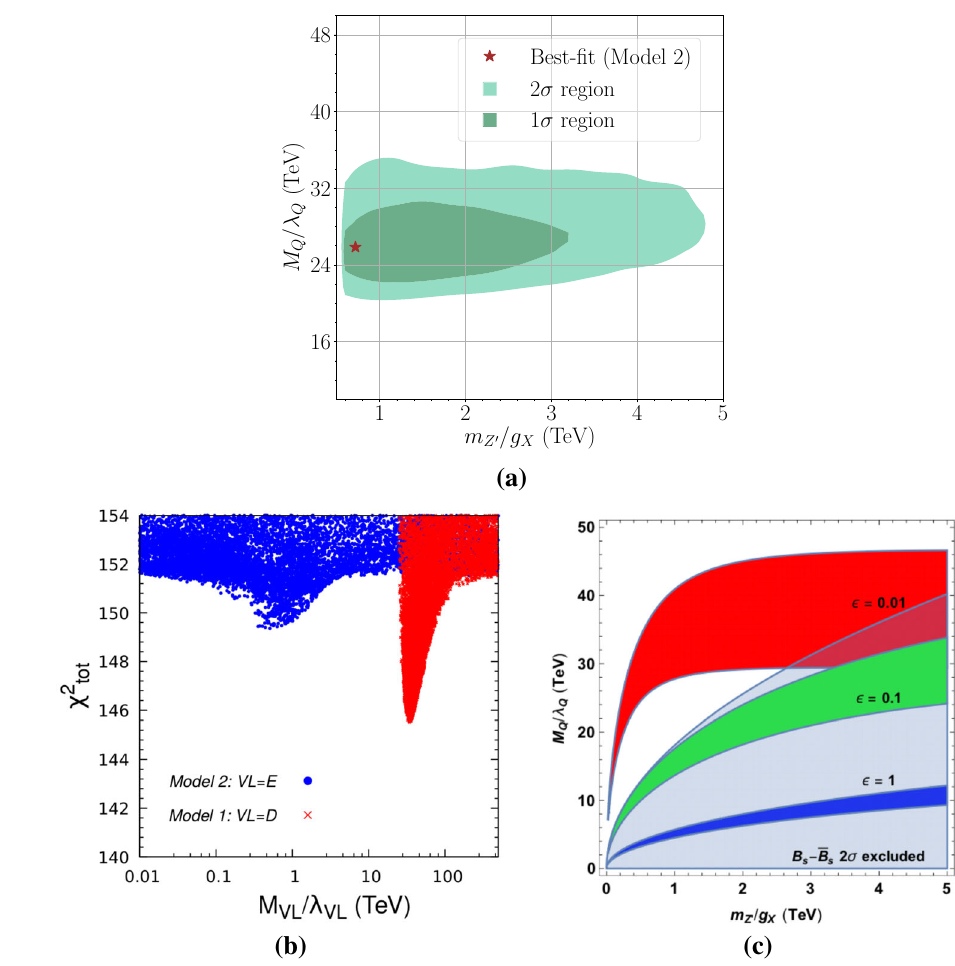
Fig. 6 a The marginalized 2-dimensional posterior pdf in the ( m Z (cid:4) / g X , M Q /λ Q ) plane in Model 2 (the pdf is very similar in Model 1). b A scatter plot of the χ 2 distribution as a function of VL mass rescaled by the Yukawa coupling for Model 1 (red, M D /λ D on the x axis) and Model 2 (blue, M E /λ E , 2 on the x axis). c The 2 σ regions of the profile likelihood in the ( m / g /λ ) plane of X , M Q Q Z (cid:4) Model 3 for different values of (cid:14) ( M /λ = (cid:14) M /λ ) . The L L , 2 Q Q gray area is excluded by the upper bound on R BB from B s mixing